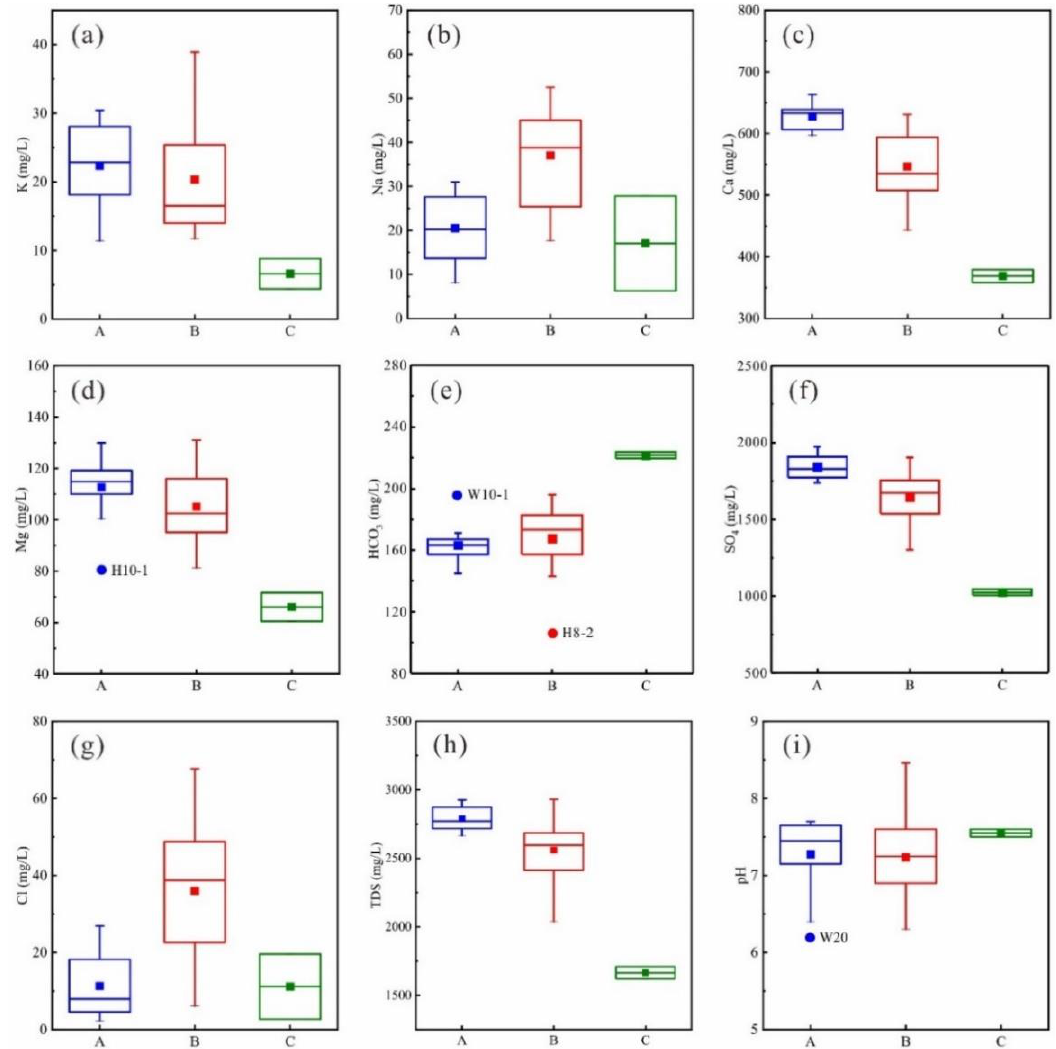
Figure 8. Box and whisker plots of concentrations of the major constituents, TDS and pH of the hot water samples of clusters A, B, and C: ( a ) for K + ; ( b ) for Na + ; ( c ) for Ca 2 + ; ( d ) for Mg 2 + ; ( e ) for HCO 3 − ; ( f ) for SO 42 − ; ( g ) for Cl − ; ( h ) for TDS; ( i ) for pH. The boxes show the upper quartile, the median and the lower quartile. The smallest and largest values are indicated by the small horizontal bars at the end of the whiskers. ■ Represents mean values; ●Represents outlier values.